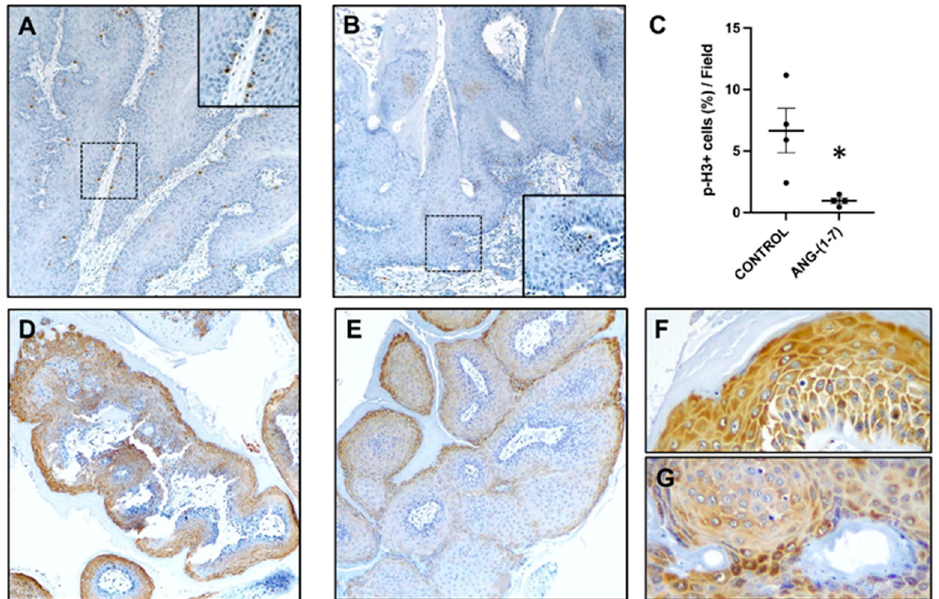
Figure 4. ( A – C ): Proliferative status of the oral papilloma from the K14-CreER tam /LSL-K-ras G12D/+ mice treated with vehicle or angiotensin-(1-7). ( A ) p-H3 expression in a control mouse. The immunostaining is widely extended in the basal layers (inset). ( B ) p-H3 expression is reduced after angiotensin-(1-7) treatment (detail depicted in the lower inset). ( C ) p-H3 positive cells were counted and quantified as a percentage of total cells. Angiotensin-(1-7) treated tumors showed a significant reduction of p-H3 labeled cells. Student t-test ( n = 4) * p < 0.05. ( D – G) pS6 immunostaining in representatives papilloma developed by K14-CreER tam /LSL-K-ras G12D/+ mice treated with vehicle ( D , F ) or angiotensin-(1-7) ( E , G ). Level of pS6 in the tumor of a mouse treated with the vehicle was more prominent and showed stronger signal intensity than the angiotensin-(1-7) treatment ( E , G ). Original magnifications: A, B X10;/ D, E X20; and F, G X40.